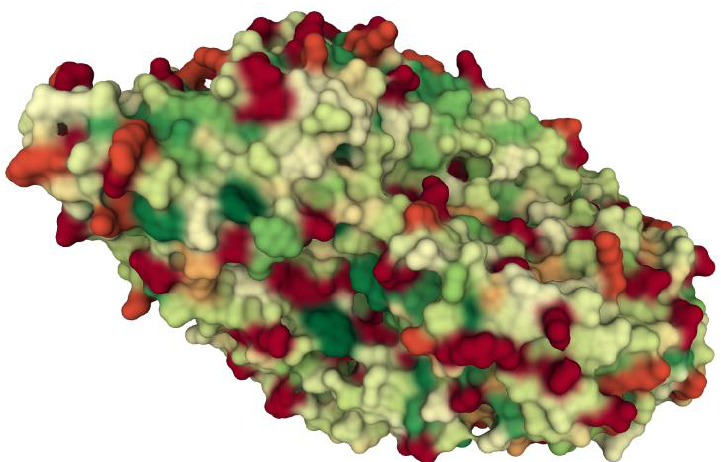
Figure 1. Hydrophobicity of β -galactosidase from Aspergillus oryzae (PDB ID: 4IUG; [21]. Molecular surface representation (red — hydrophilic residues; green — hydrophobic residues).